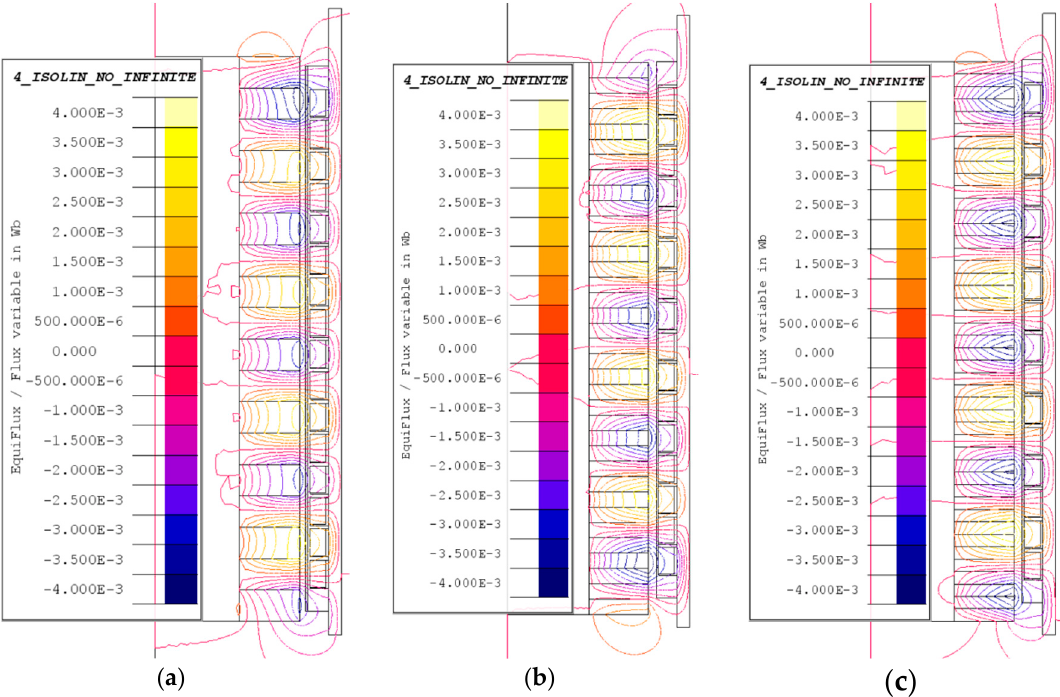
Figure 10. Flux distribution on the three different models under no-load condition: ( a ) classical Halbach array; ( b ) 4-segment; ( c ) 5-segment.